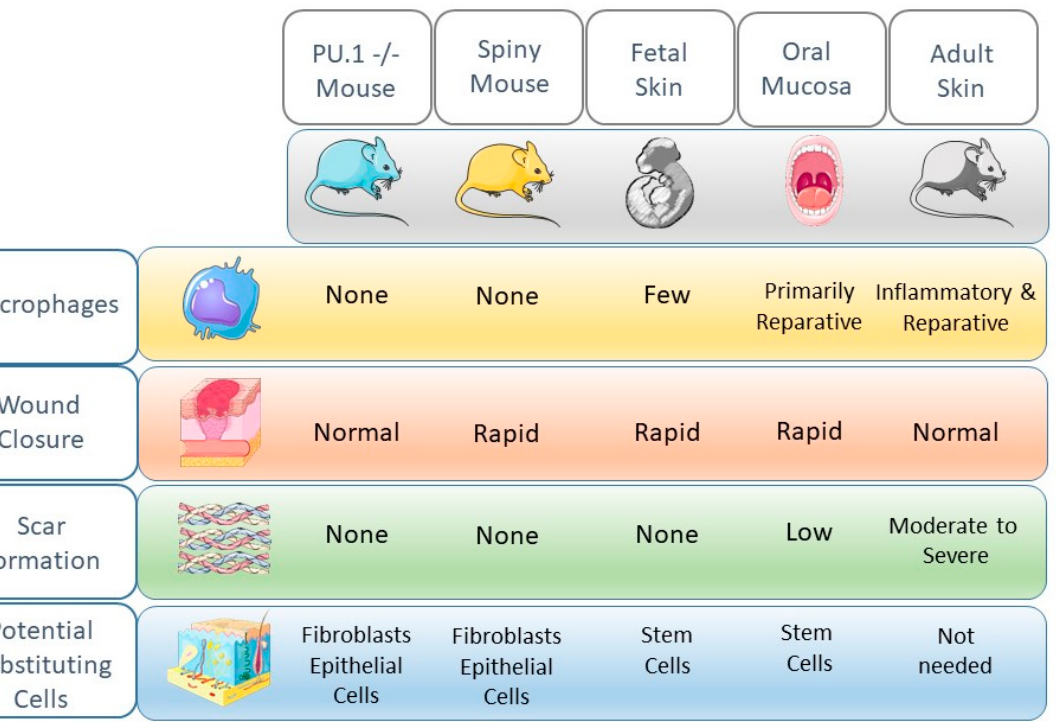
Figure 1. Comparison of healing phenotypes, macrophage content, and possible cells that might substitute for macrophages. Several model systems show that wounds can heal well in the absence of or with a reduction in the macrophage population. In many cases, the absence of macrophages might be compensated for by other cell types that can adopt new functions. Artwork is courtesy of Smart Servier Medical Art, freely available at https://smart.servier.com/.